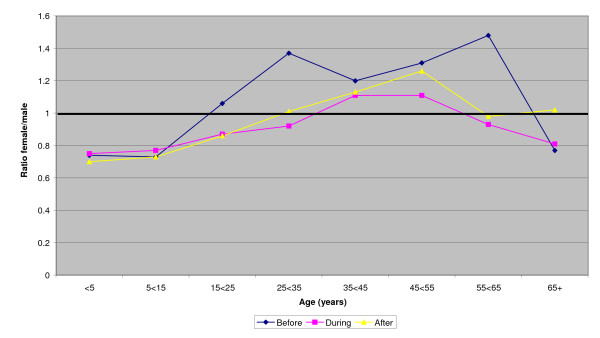
Female/male ratios by age groups for registrations before, during and after the intervention: intervention township. Gender determined disease and THC inpatients omitted (ratios corrected for population ratios - see text)